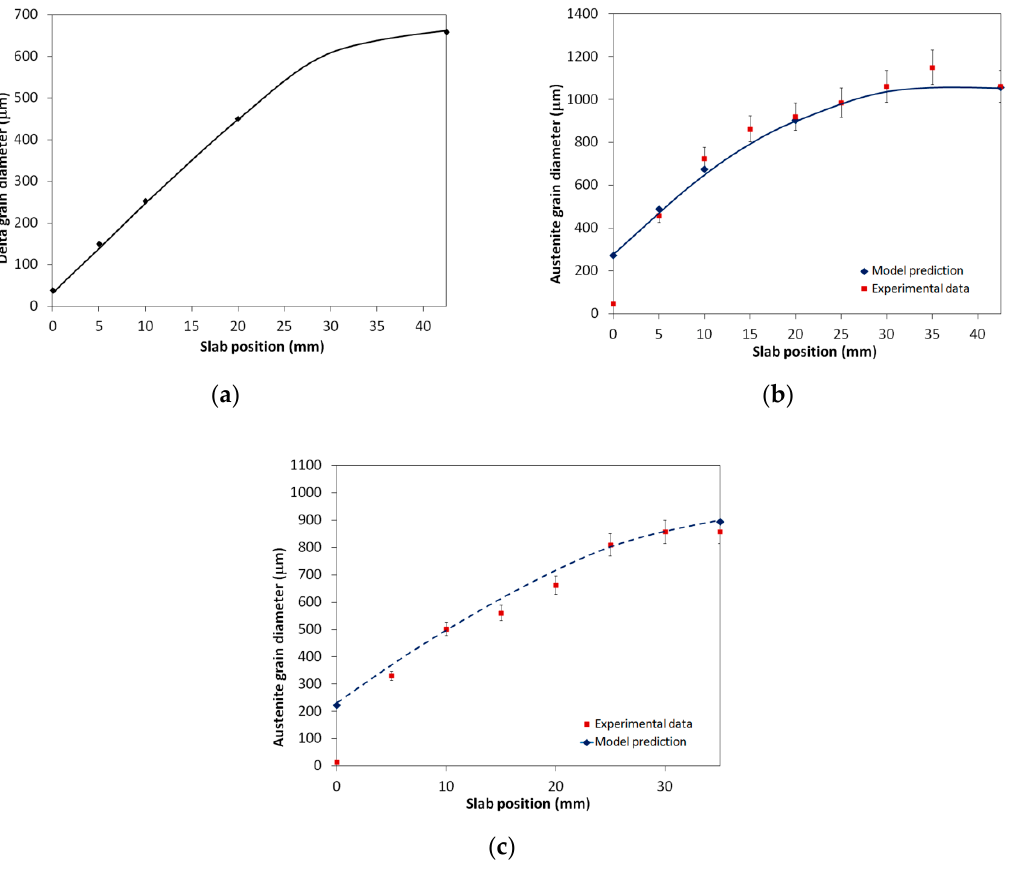
Figure 6. ( a ) The predicted delta grain size as a function of slab position; ( b ) comparison of model prediction and experimental measurement of austenite grain size with slab position before the 85 mm slab enters the holding furnace; and ( c ) comparison of model prediction and experimental measurement of austenite grain size with slab position before the 70 mm slab entering the holding furnace.